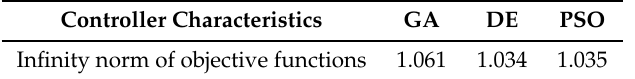
Table 7. Comparison of the objective function peaks resulting from different tuning methods.